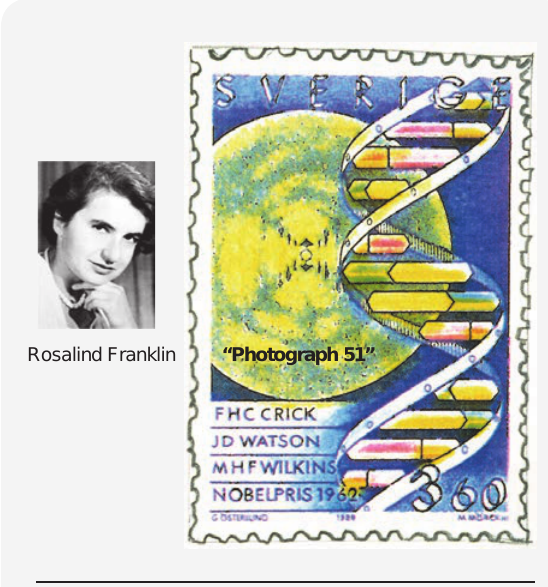
Figure 3. Rosalind Franklin’s ‘Photograph 51’ and the diffraction cross proving DNA is a